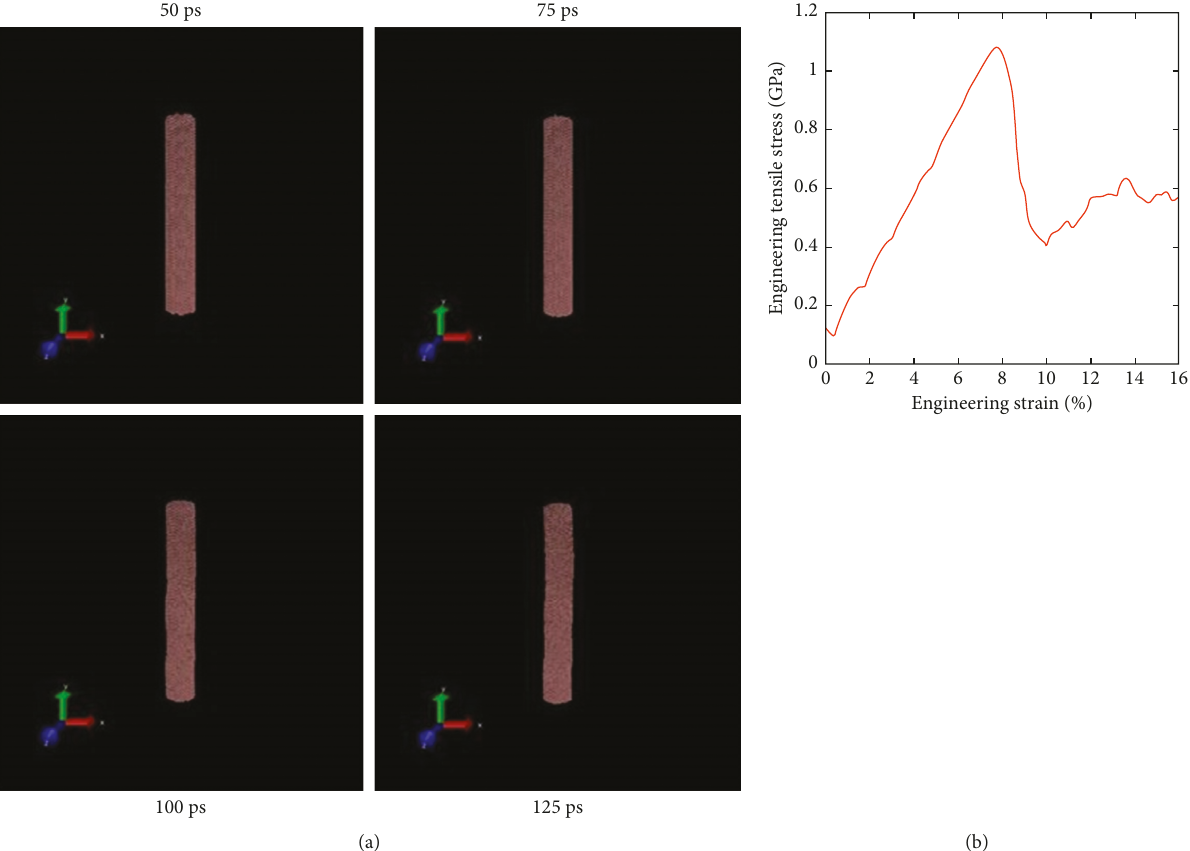
Figure 1: The snapshots showing the deformation of Au nanowire with time. The simulation parameters are given in Table 1. The stress- strain curve has been shown in the right.